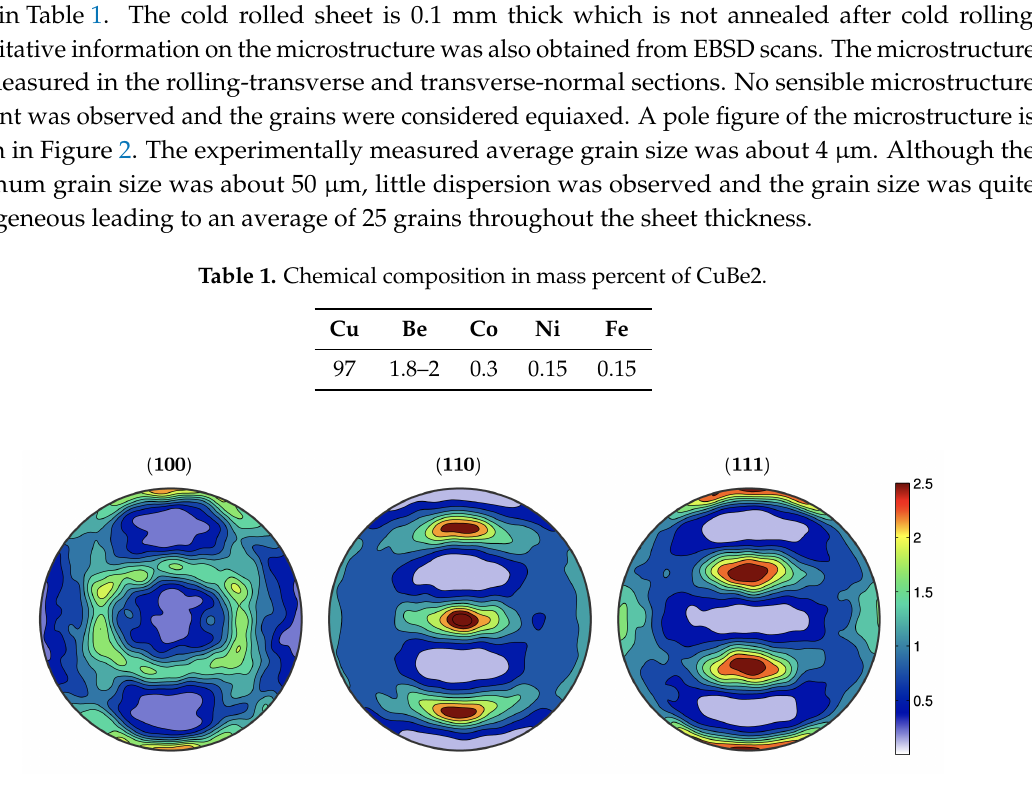
Figure 2. Pole figure of the copper beryllium alloy CuBe2. Directions are indicated above the figures.